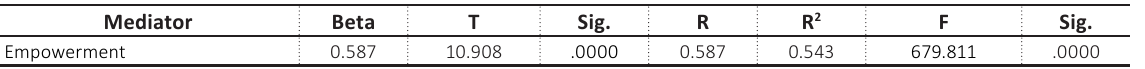
Table 9. Relationship between empowerment and internal work environment